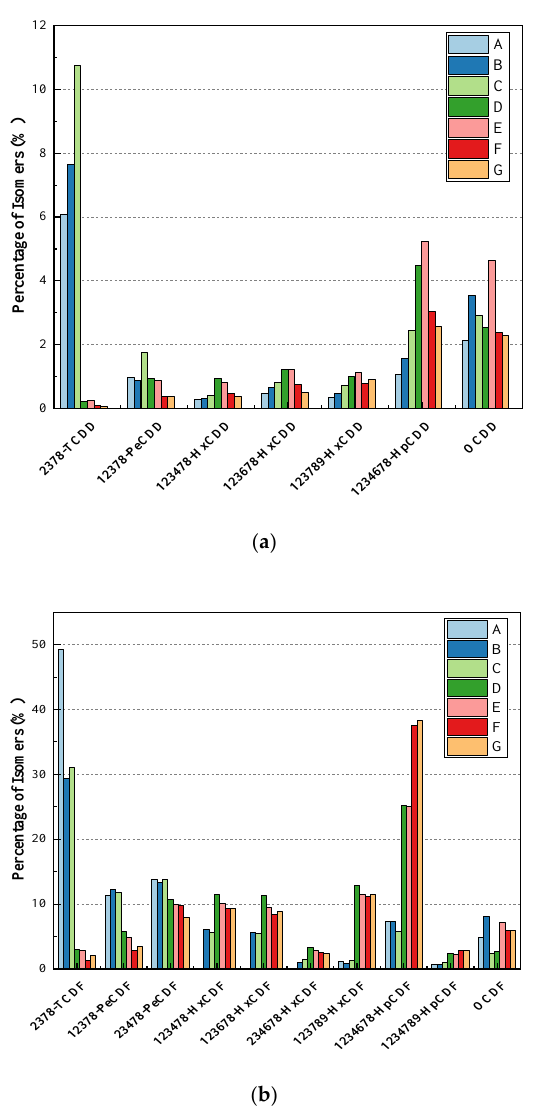
Figure 7. Distribution of the 17 dioxin isomers for Groups A – G. ( a ) Isomers of PCDDs, ( b ) isomers of PCDFs.